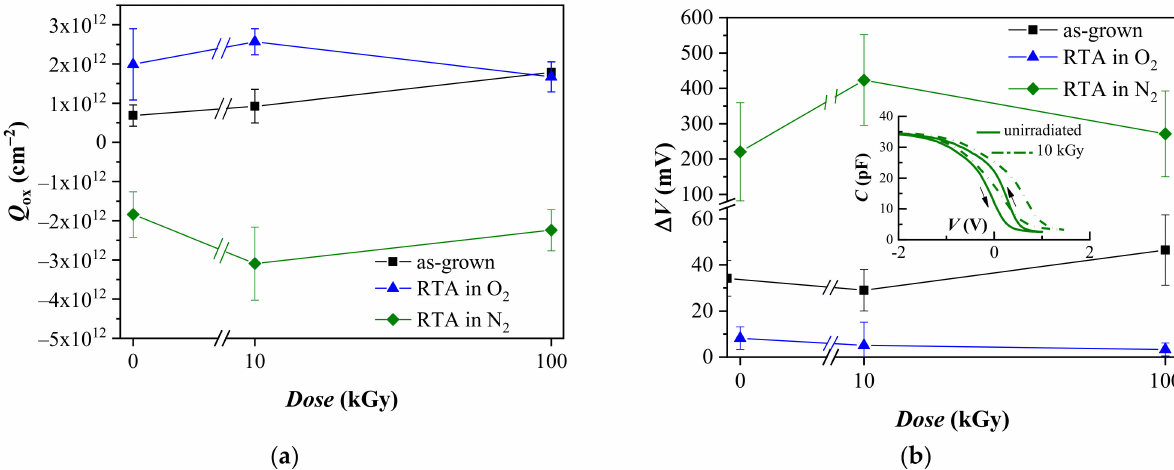
Figure 1. The initial oxide charge ( a ) and C - V hysteresis ( b ) of stacks before and after γ -irradiation. The inset in ( b ) illustrates the C - V hysteresis of stacks annealed in N 2 : solid line pristine and dash-dot line after irradiation with 10